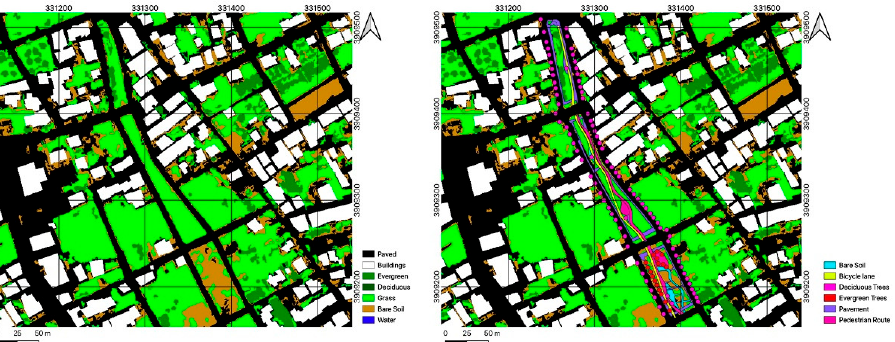
Figure 5. Current surface cover ( left ) and planned changes ( right ).